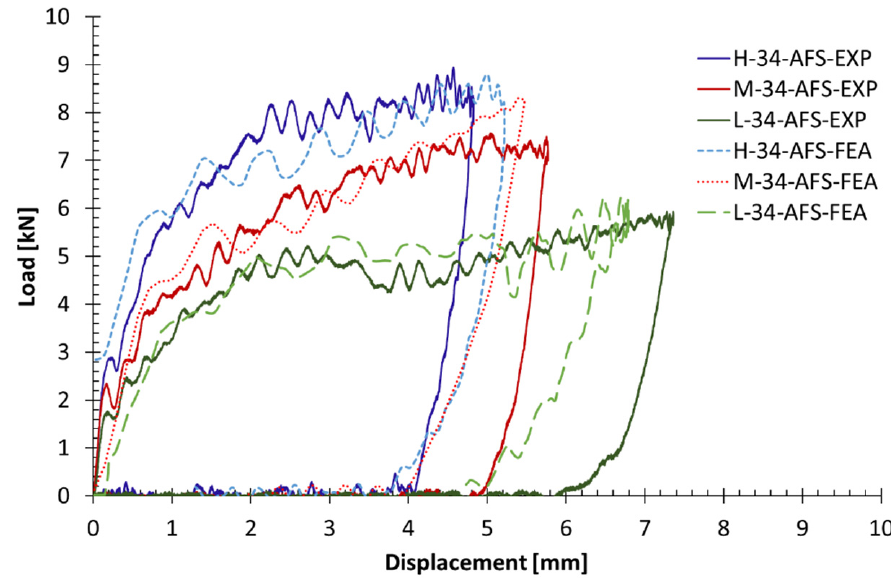
Figure 8. FE and experimental load-displacement curves of the aluminum sandwich panels.